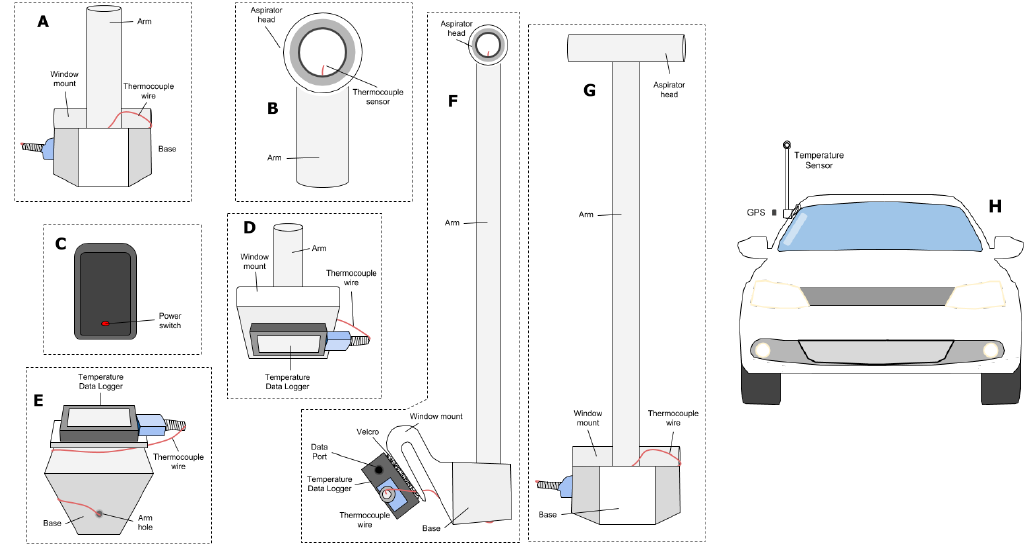
Figure 2. Rendering of Sensor Setup. ( A ) Front of base; ( B ) Aspirator detail; ( C ) GPS unit; ( D ) Back of base; ( E ) Bottom of base; ( F ) Profile of device; ( G ) Front of device; ( H ) Approximate scale of device and GPS unit (GPS unit kept inside of vehicle). Adapted with permission from Makido et al., 2016 [24].